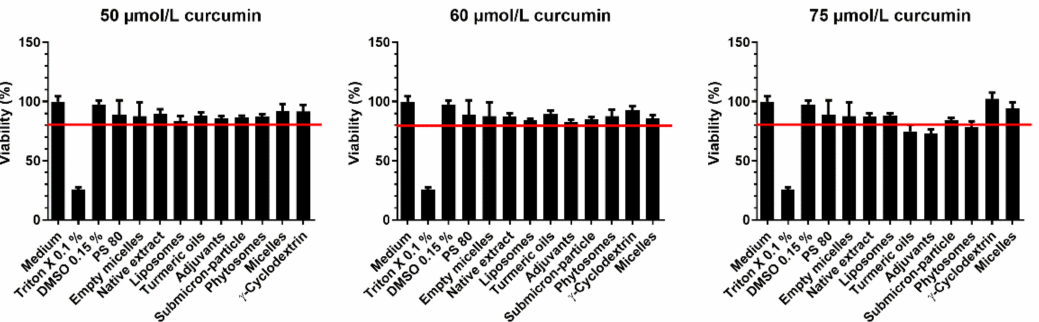
Figure A1. Mean ( ± SEM) viabilities (% of medium control) of LS180 after 1 h incubation at 37 ◦ C and 5% CO 2 with native curcumin or one of the seven formulations normalized to 50, 60, and 75 µ mol/L curcumin. Medium control (100% viability) served as a reference, DMSO as the solvent control and Triton X 0.1% as the positive control. The red line shows 80% viability. PS 80, polysorbate